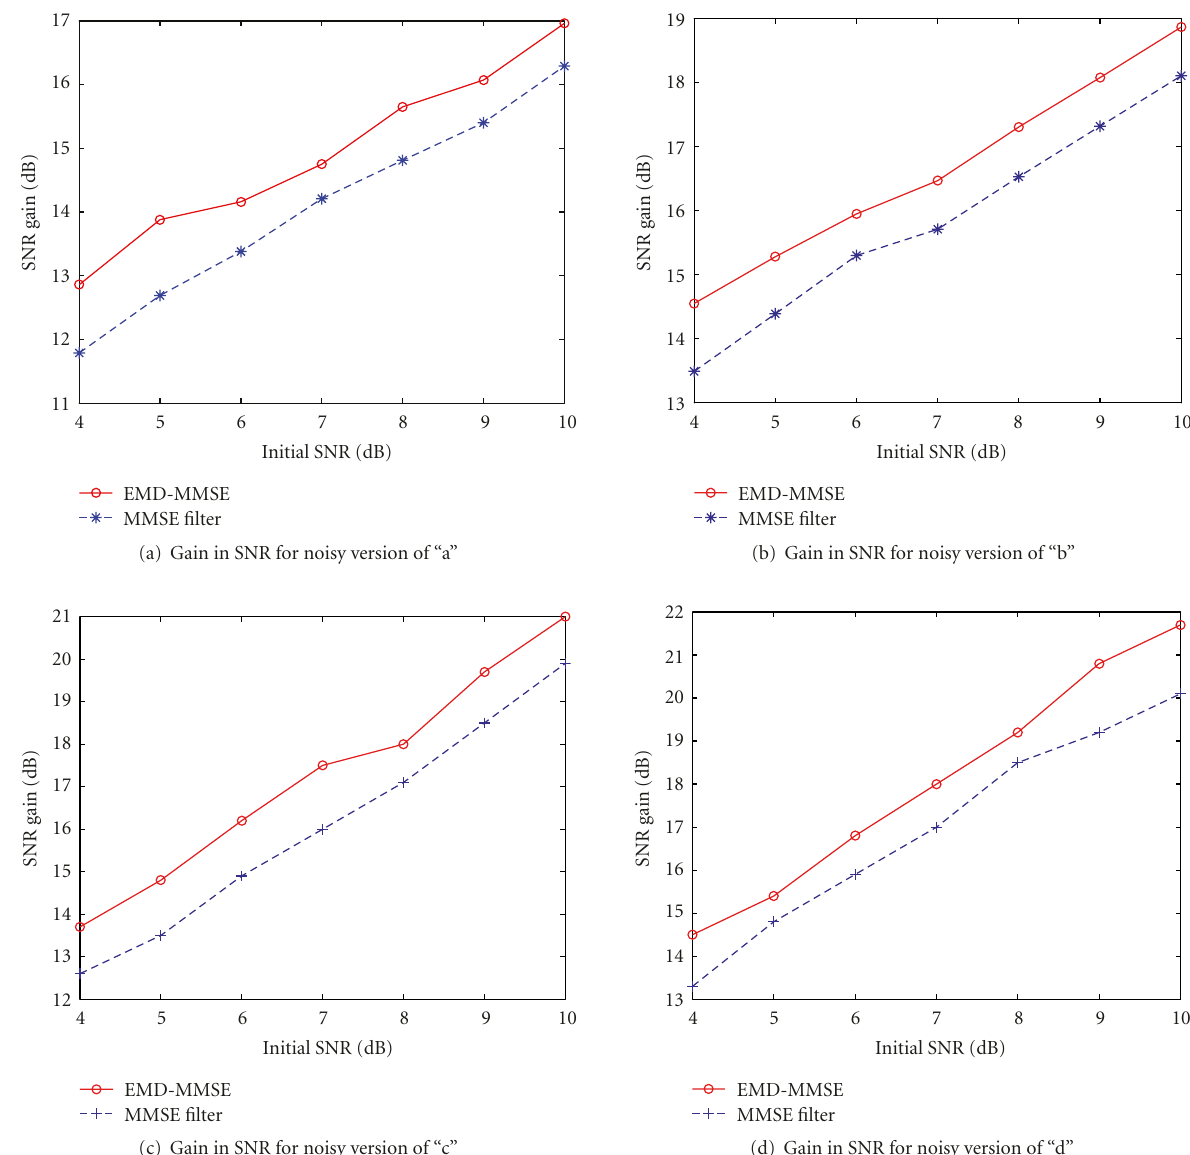
Figure 4: Final SNR values obtained for di ff erent initial noise levels of signals “a”, “b”, “c”, and “d”. The results are the average of 100 instances signal. It is reported for EMD-MMSE and the MMSE